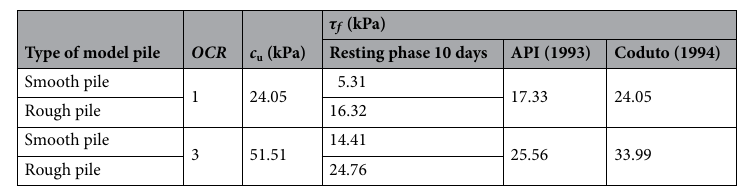
Table 3. Test values and predicted values for ultimate pile side friction resistance (overburden pressure of soil 50